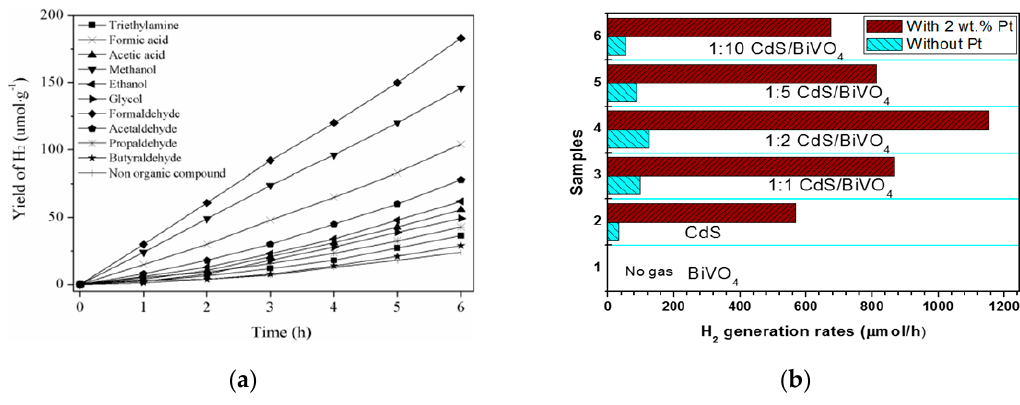
Figure 5. ( a ) Effects of different organic compounds on hydrogen production in ZnIn 2 S 4 /RGO/BiVO 4 photocatalyst. Reproduced with permission from [106]. Copyright Elsevier, 2019; ( b ) Photocatalytic H 2 generation rates of different mass ratios CdS/BiVO 4 in lactic acid solution with or without 2 wt.% Pt under visible light irradiation. Reproduced with permission from [103]. Copyright Elsevier, 2017.